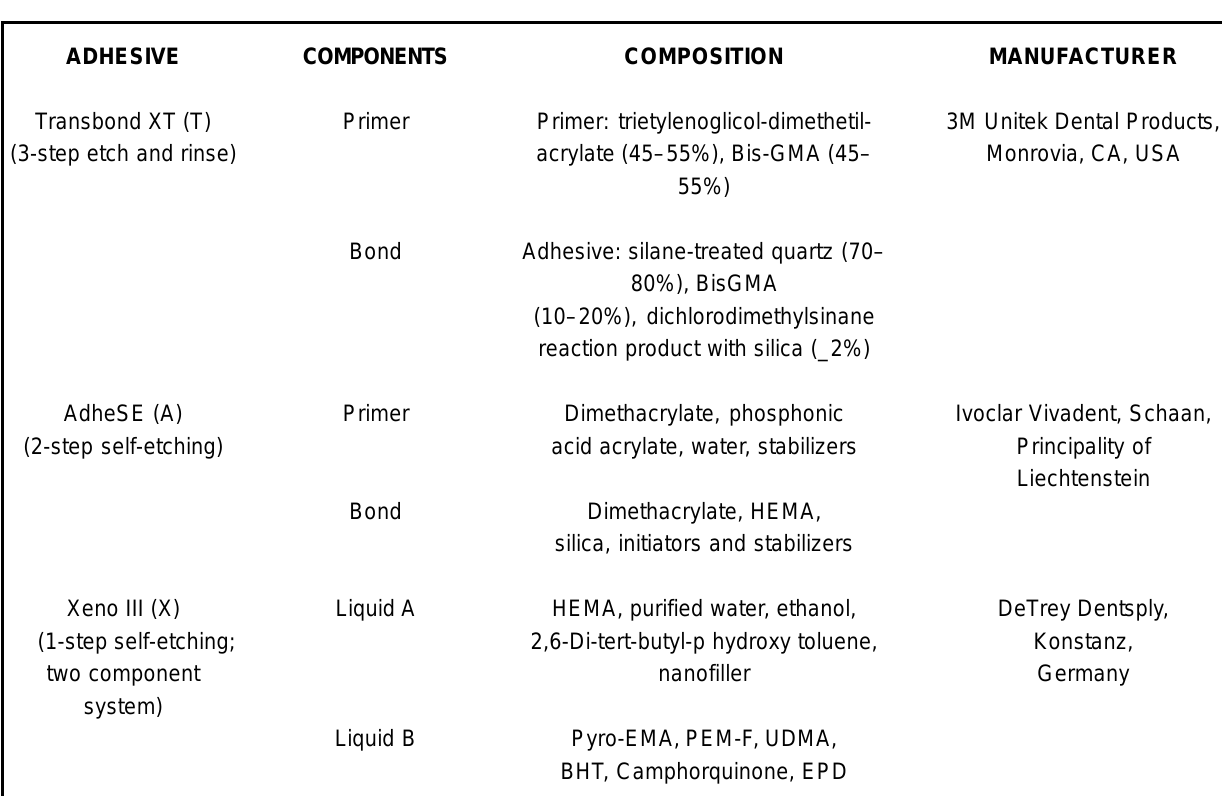
FIGURE 1- Components, formulations and manufacturers of the tested adhesive